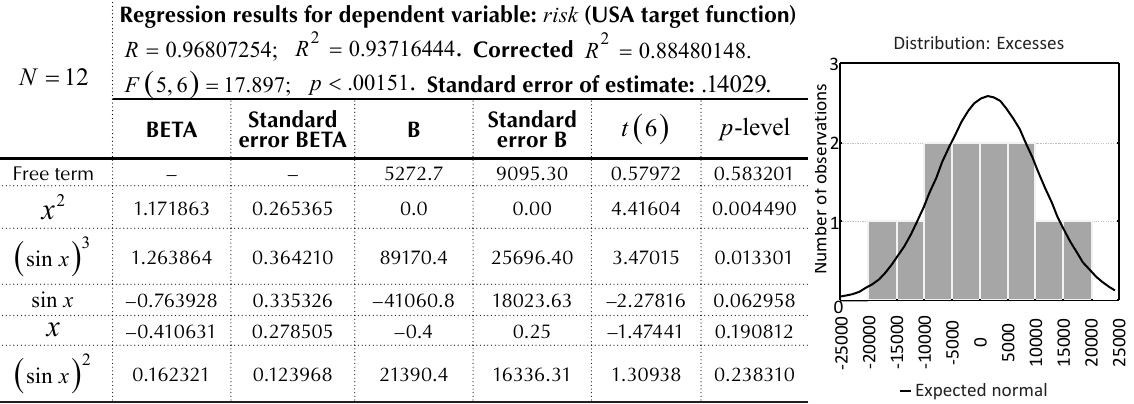
Table 2b. The results of regression for contributions of the members of the Securities Investor Protection Corporation (SIPC) ( ) c from its volume ( ) x Regression results for dependent variable: 12 N =